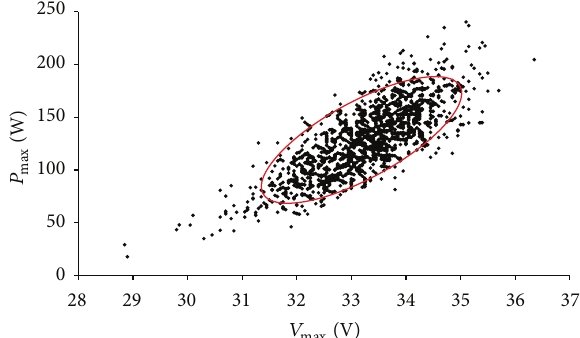
Figure9:Thedefinitionofhittingzoneforthe2ndsetofexperiment data.